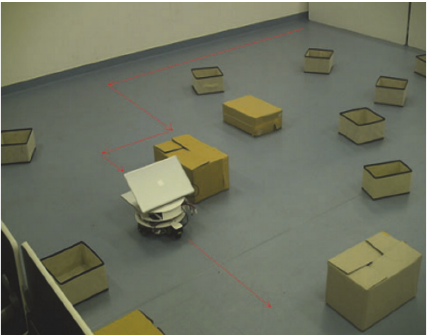
Figure 3: Controlling mobile robot navigation using bacteria memetic algorithm (source, Botzheim, Toda and Kubota [189]).